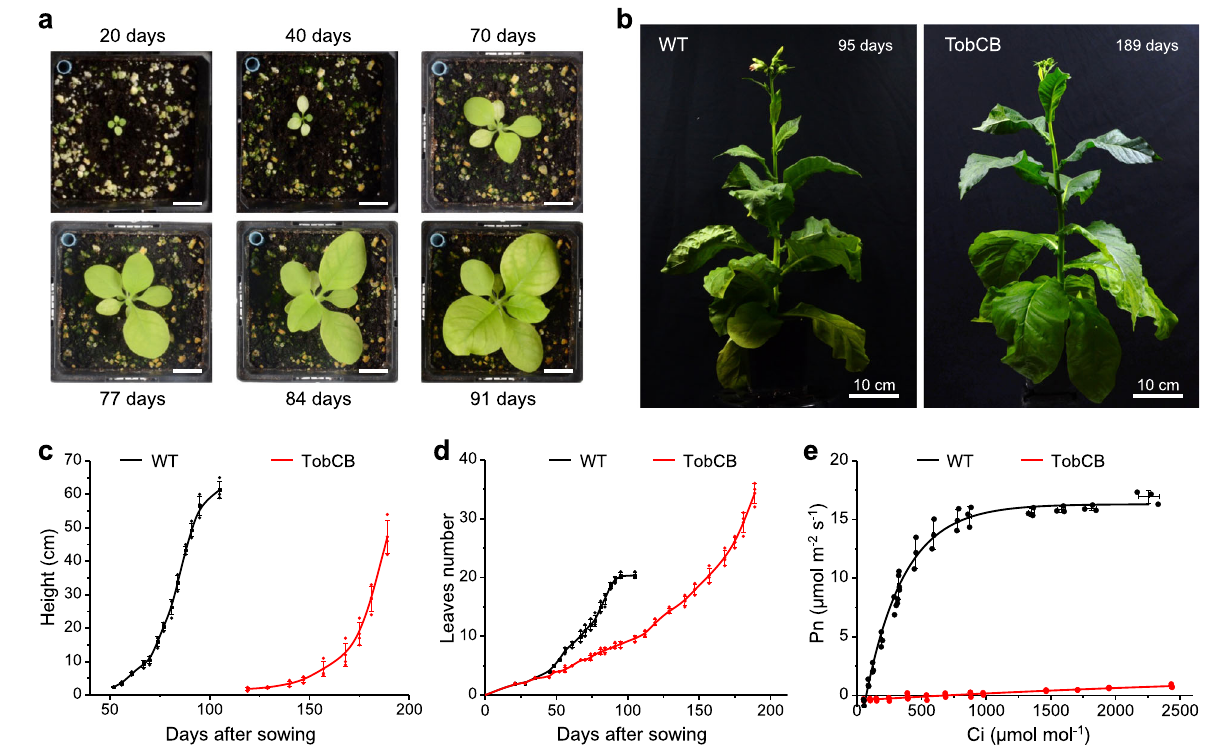
Fig. 4 | Carboxysome-mediated plant growth. a The growth of TobCB in air supplemented with 1% CO 2 after sowing. Scale bar: 2cm. b Growth phenotypes of WT (95 days after sowing) and transgenic plants (189 days after sowing) in air supplemented with 1% CO 2 . c , d Plant growth curves indicated as height ( c ) and leaves number ( d ) after sowing. e Leaf gas-exchange analysis of net CO 2 photo- synthesisrate(Pn)ofWTandTobCBasafunctionofintercellularCO 2 pressures(Ci)